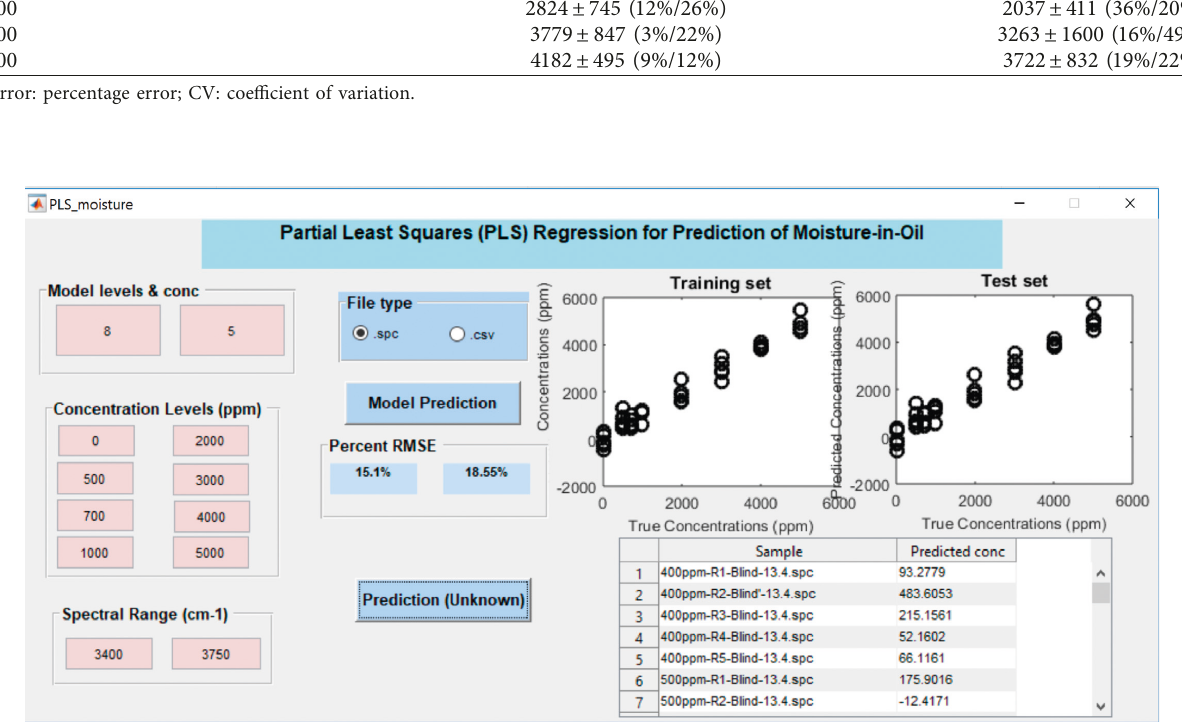
Figure 6: The interface of the PLSR moisture prediction